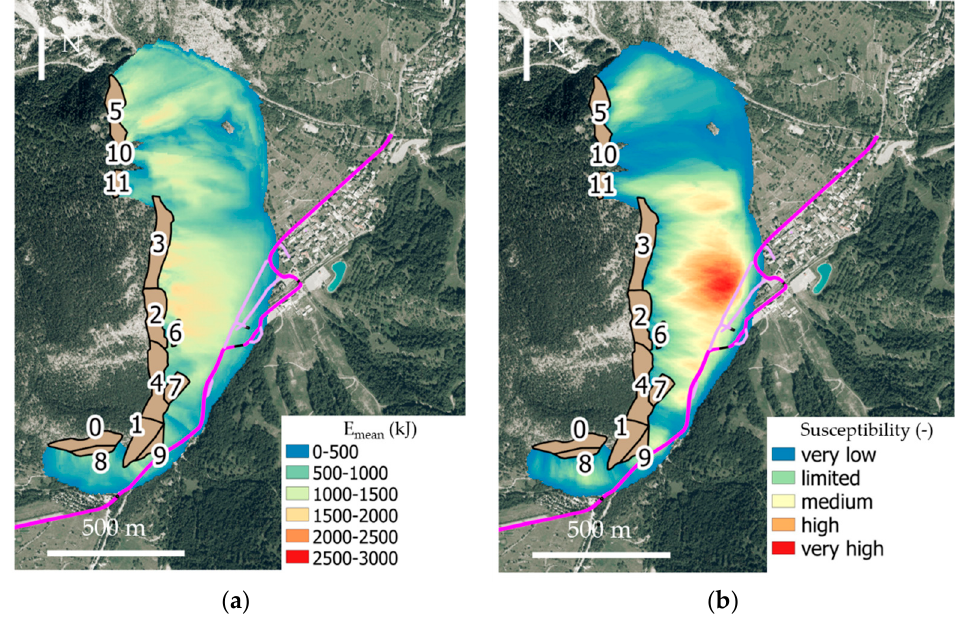
Figure 18. QPROTO results for the site of Melezet. Source areas are shown in light brown, local viability in pink, provincial road no. 216 in magenta, bridges in black. ( a ) Mean energy in kJ, ( b ) susceptibility. Orthophoto AGEA 2018.